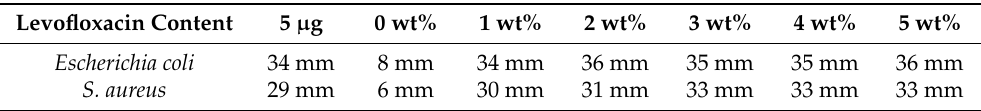
Table 2. Table of inhibition zone diameters of gelatin/genipin/levofloxacin membranes against Escherichia coli and S. aureus